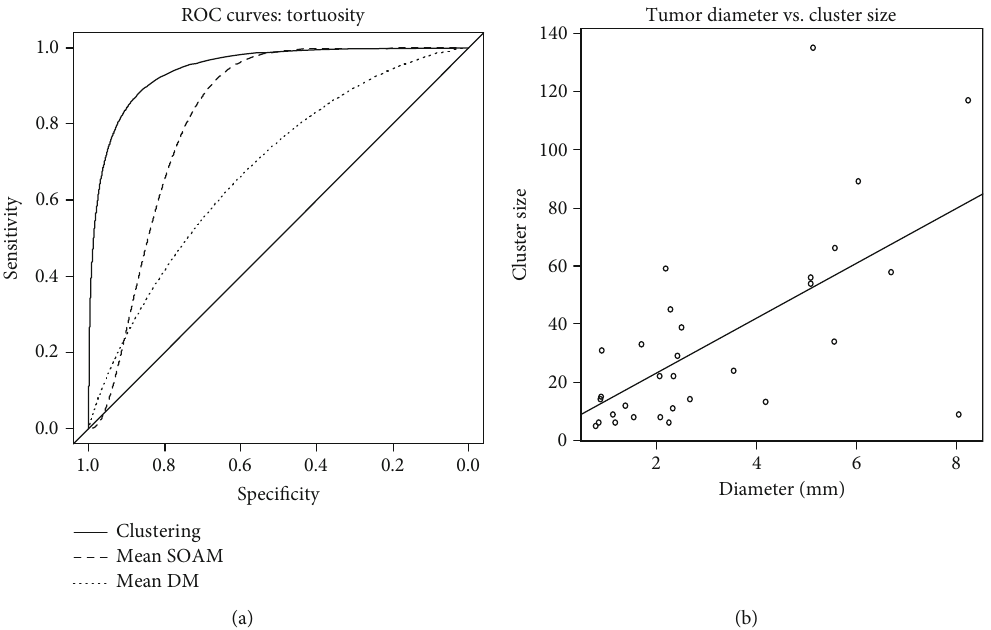
Figure 6: (a) ROC curves for di ff erentiation between tumor and control images using tortuosity metrics. AUC = 0 : 95 , 0.82, and 0.68. (b) Scatterplot of tumor diameter versus maximum cluster size and linear regression line ( p = 1 : 3 × 10 − 4 and R 2 = 0 : 37 ).